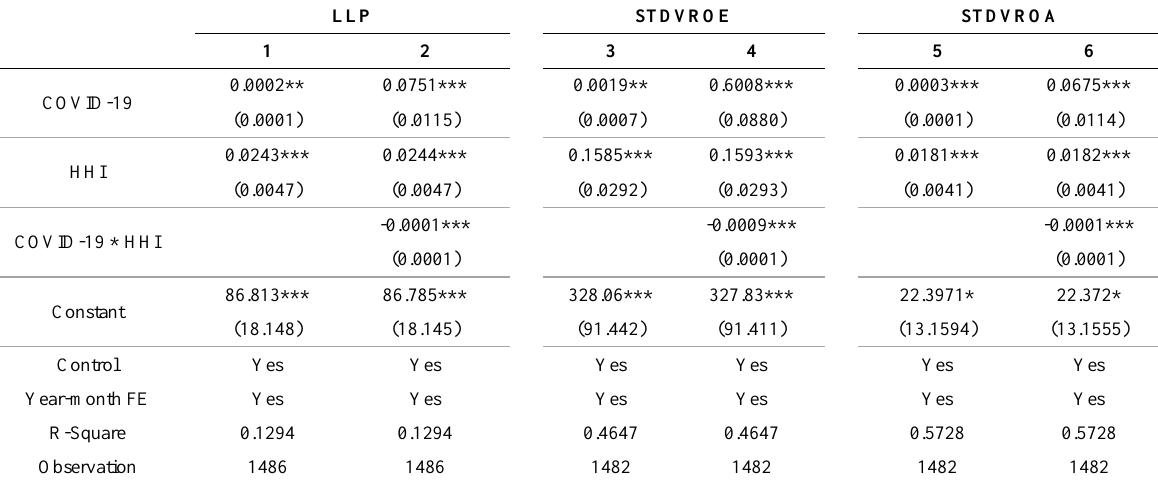
Table 5. Robustness Tests; Alternative Measures of Bank Stability